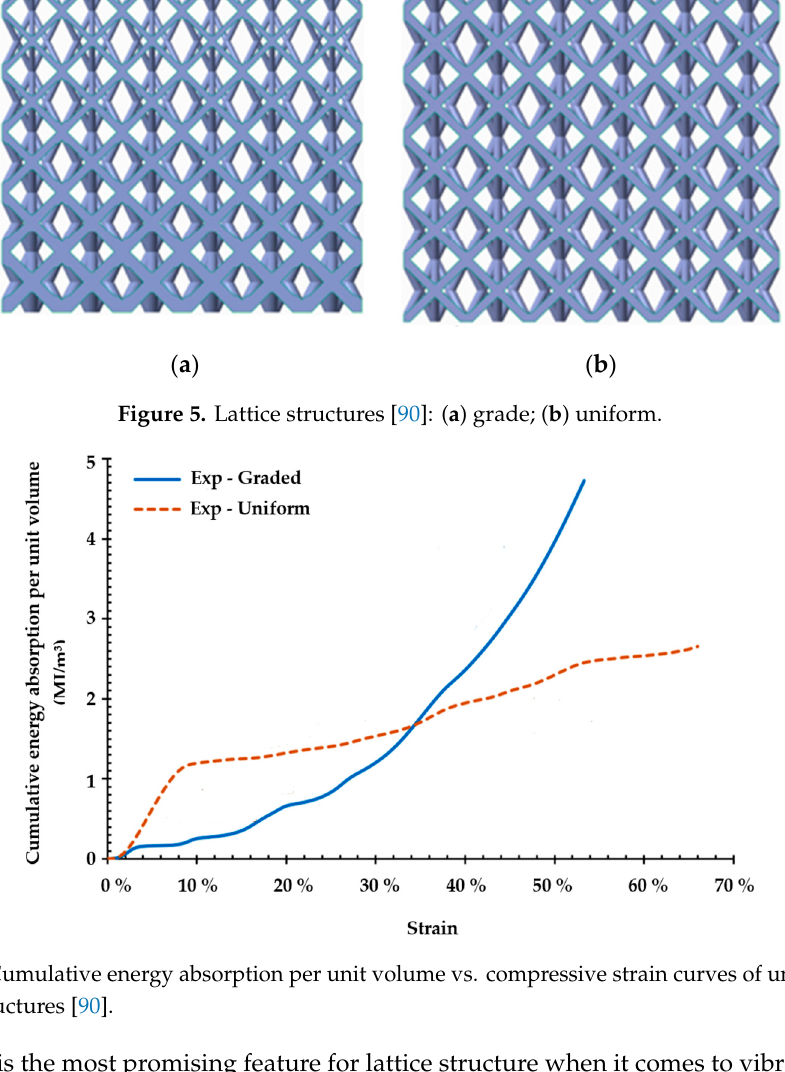
( f ) Figure 7. FEA simulations to estimate displacement of six lattice structures [92]: ( a ) model 1; ( b ) model 2; ( c ) model 3; ( d ) model 4; ( e ) model 5; ( f ) model 6. (4) Dissipate heat [27,44–46,78,97–100]. Wadley and Queheillalt [45] compared copper textile- based lattice structures with selected heat dissipation media including stochastic open-cell metal foams, periodic Kagome and lattice frame materials, corrugated ducts and louvered fins. Wadley and Queheillalt [45] pointed out that although the copper textile-based lattice structures performed as well as the stochastic open-cell metal foams (aluminum and copper based), the pumping power